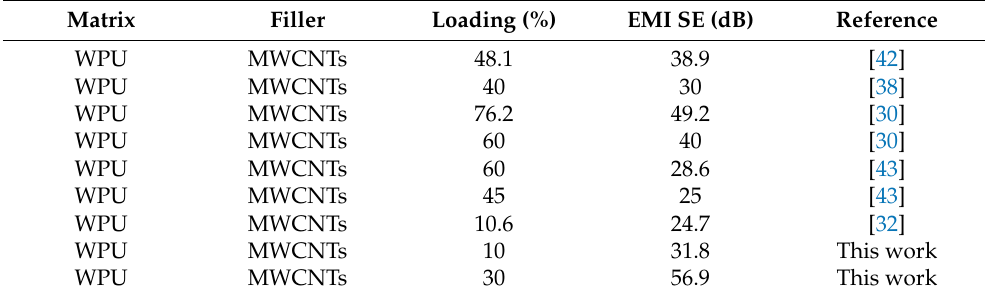
Figure 9. ( a ) EMI SE T of CNTs/OCWPU with various CNTs content. ( b ) Comparison of the mean values of absorption shielding ( SE A ), reflection shielding ( SE R ) and total shielding ( SE T ) as a function of CNTs content. ( c ) Average of SE R and reflectivity of samples at X-band. ( d ) Schematic of EMI shielding mechanism of CNTs/OCWPU composite films. Table 1. EMI shielding performance in the X-band of reported WPU-based